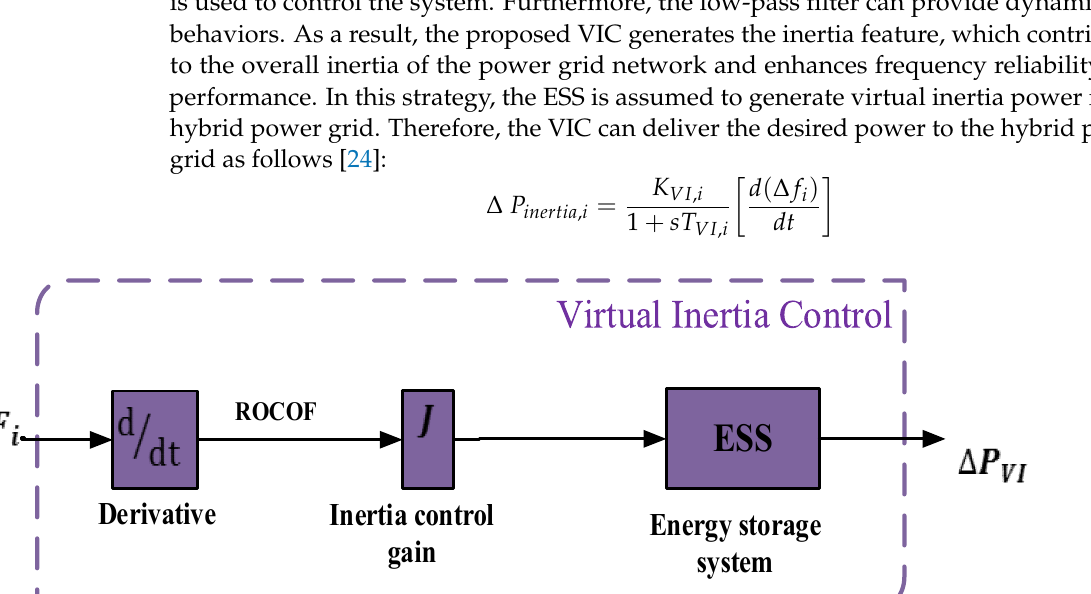
Figure 3. The dynamic model of inertia control-based energy storage devices.